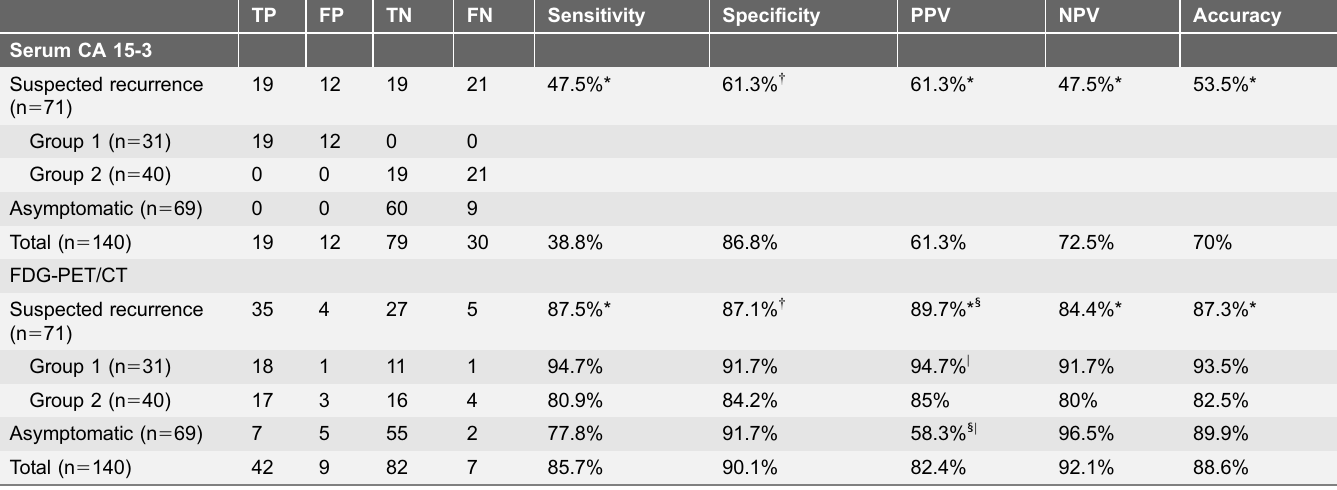
Table 4. Effectiveness of CA 15-3 and FDG-PET/CT in detecting recurrent breast cancer in patients with suspected recurrence and in asymptomatic